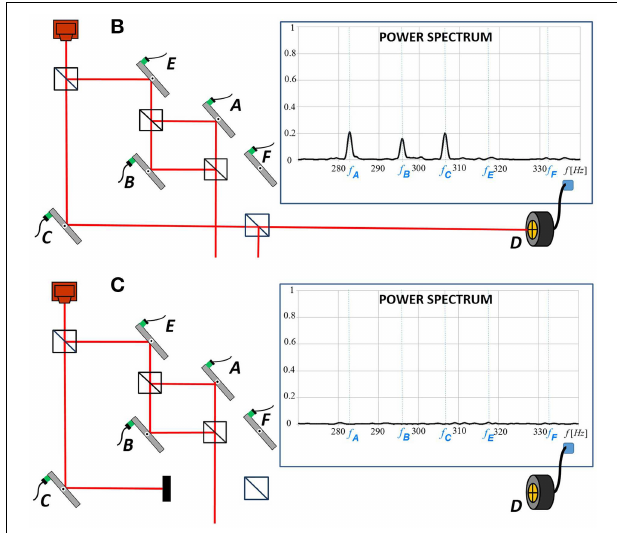
FIGURE 1 | Reproduction of panels (B) and (C) of Figure 2 from [2]. When the inner interferometer is tuned in such a way that the beam of light passing through it does not reach the photo-detector, the power spectrum of the signal in the photo-detector still shows frequencies of the mirrors of this interferometer. (C) These frequencies (and all other signals) disappear when we block the lower arm of the large interferometer without changing anything in the upper